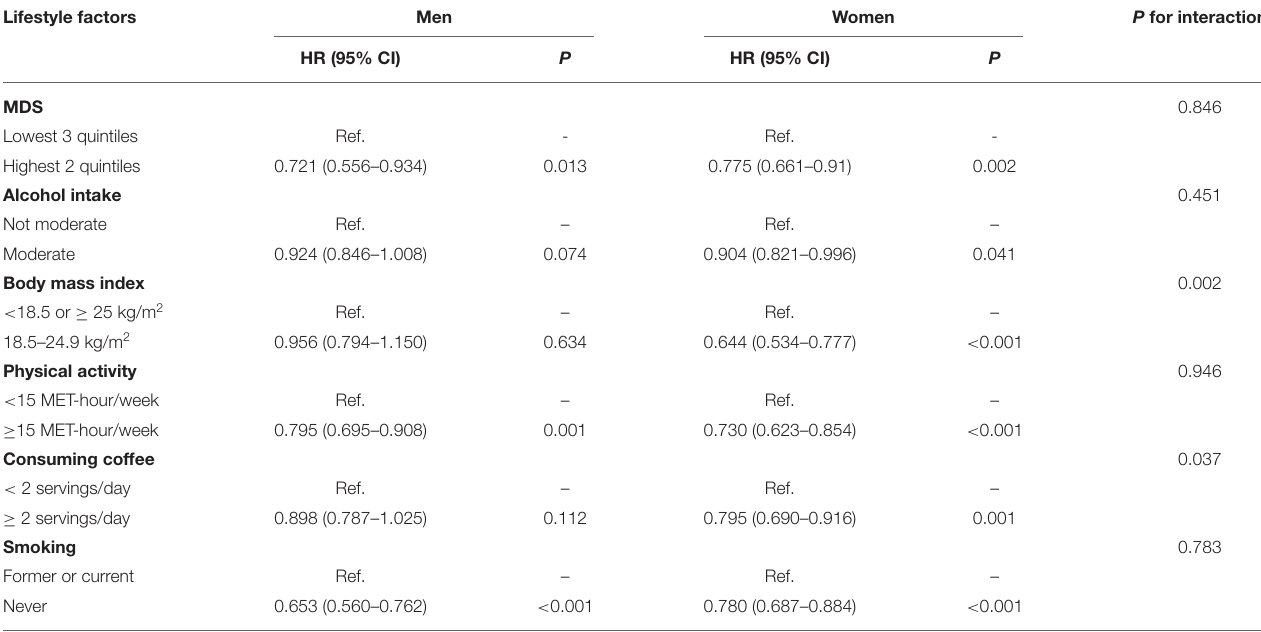
TABLE 3 | Multivariable Cox regression model for association of healthy lifestyle factors and all-cause mortality for man and woman. Lifestyle factors